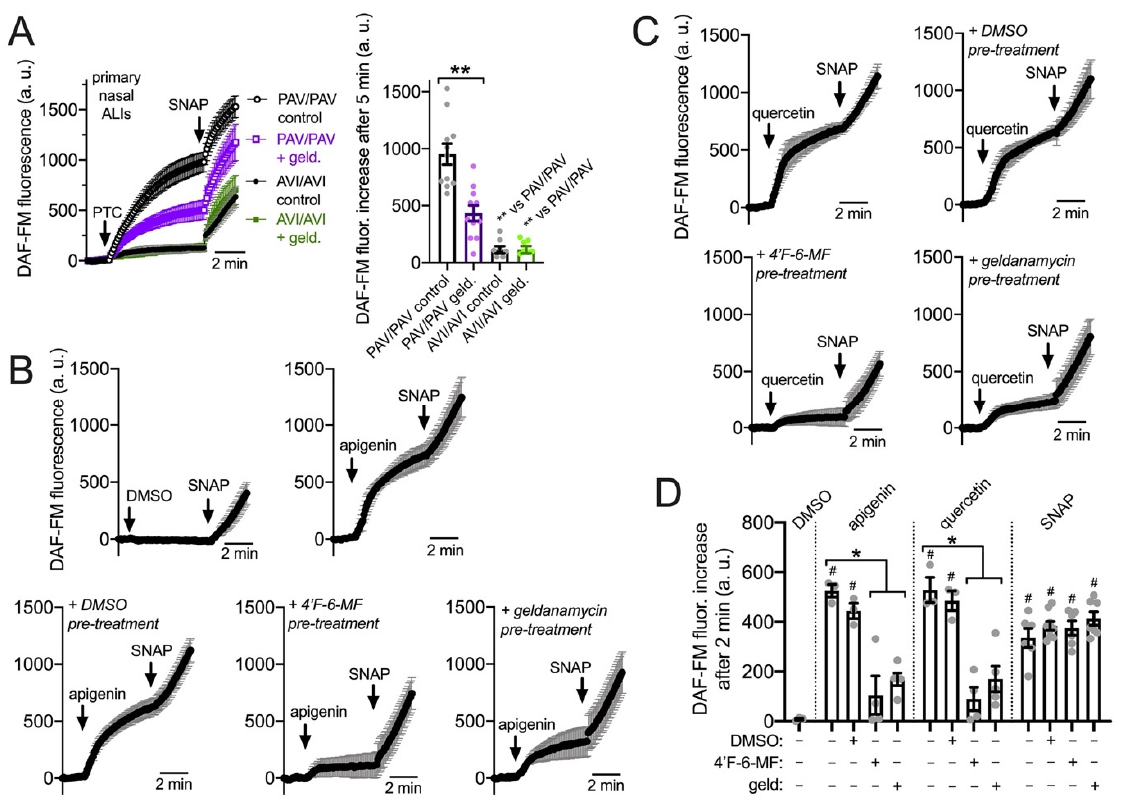
Figure 3. T2R bitter taste receptor expression in airway cell cilia. Representative images of cilia marker β -tubulin IV (green), T2R38 (cyan) and T2R14 (magenta) immunofluorescence in an apical confocal section of primary human sinonasal ALI. ( Left ) shows conventional look-up table (LUT) and ( right ) shows inverted LUT. Scale bar is 20 µm.